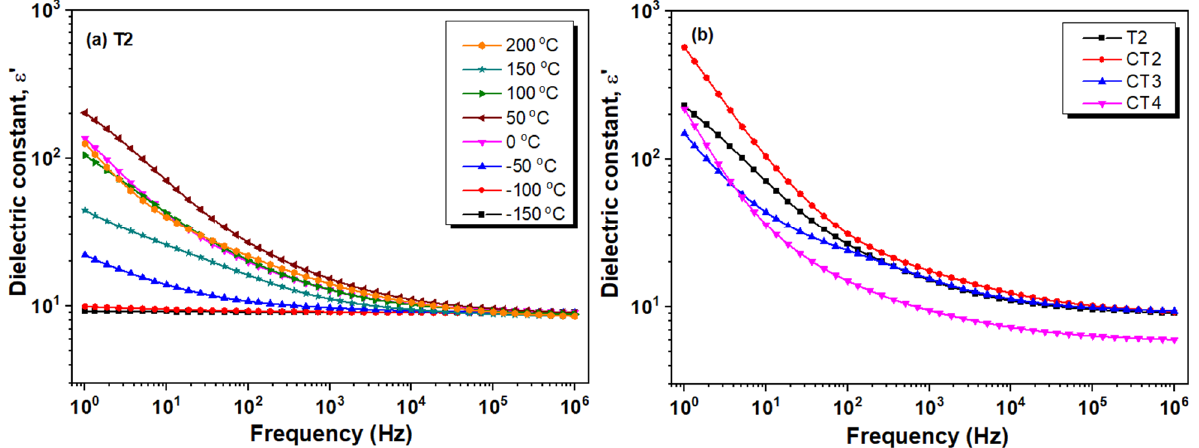
Figure 9. The evolution of dielectric constant as a function of frequency: ( a ) exemplarily for T2 at various temperatures and ( b ) comparatively for all examined samples at room temperature.